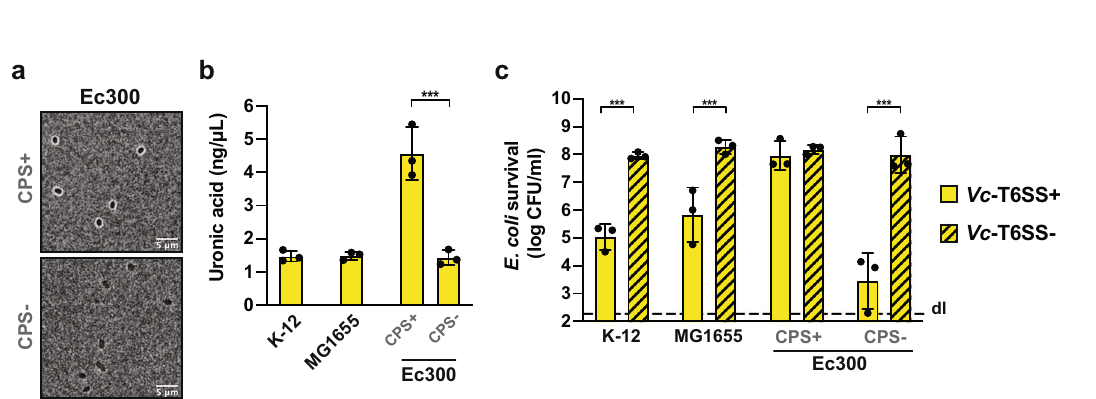
Fig. 5 Group I capsule-mediated T6SS shielding is a broad protection mechanism that can be horizontally-transferred. a – c Horizontally acquired capsule biogenesis gene cluster confers protections to E. coli against T6SS attacks. a , b Capsule visualization and uronic acid quanti fi cation of the dog commensal E. coli strain Ec300. a CPS + (Ec300; WT) and CPS − (Ec300 Δ rfaH) E. coli bacteria were imaged after India Ink staining. Representative images are shown. Scale bar, 5 μ m. b The production of uronic acid was quanti fi ed in Ec300, its CPS-minus mutant ( Δ rfaH), and two laboratory reference E. coli strains as controls. c Encapsulated E. coli is protected from T6SS assaults by V. cholerae . WT (CPS + ) and the capsule-minus (CPS − ) Ec300 bacteria as well as two reference E. coli strains were cocultured with T6SS + (WT; plain bars) or T6SS − ( Δ vipA; stripped bars) V. cholerae . Their survival is indicated on the Y -axis. b , c Values are derived from three independent experiments and the bars represent the mean (±SD, as de fi ned by the error bars). dl, detection limit, as indicated by the dashed line. Signi fi cant differences were determined using a two-sided Student ’ s t -test corrected for multiple comparisons. Only signi fi cant differences are indicated. *** p < 0.001. Source data underlying all panels are provided in the Source data fi